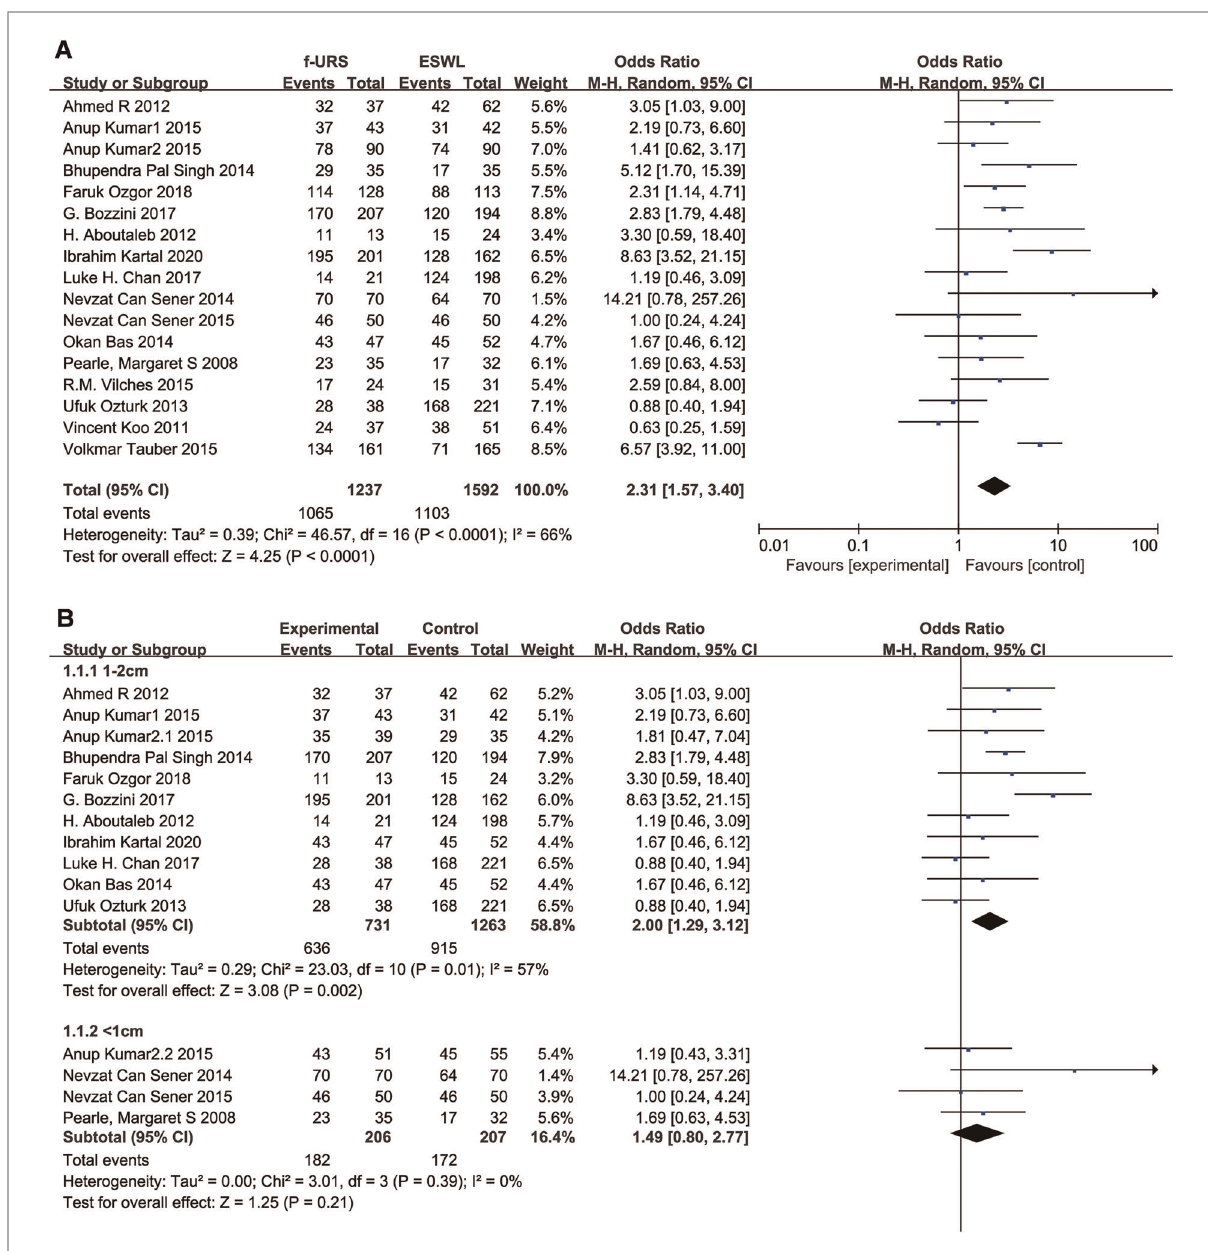
FIGURE 3 Forest plot and meta-analysis of stone-free rate for ( A ) all studies and ( B ) subgroups of stone length 1 – 2 cm and <1 cm for f-URS and